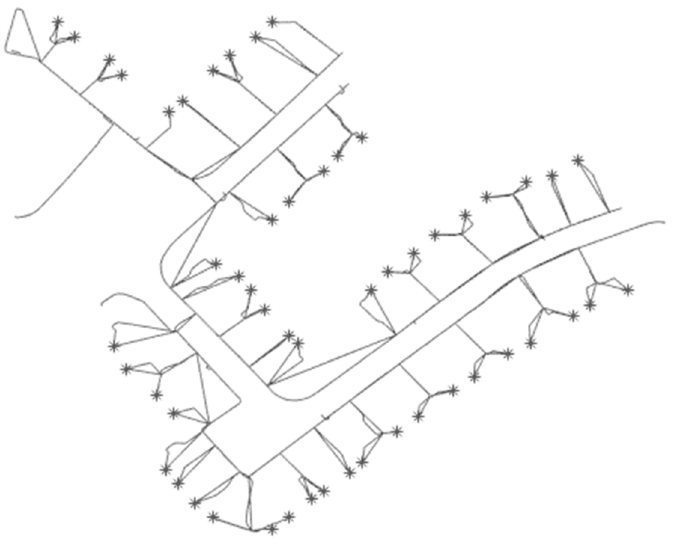
Figure 4. IEEE European LV test network.